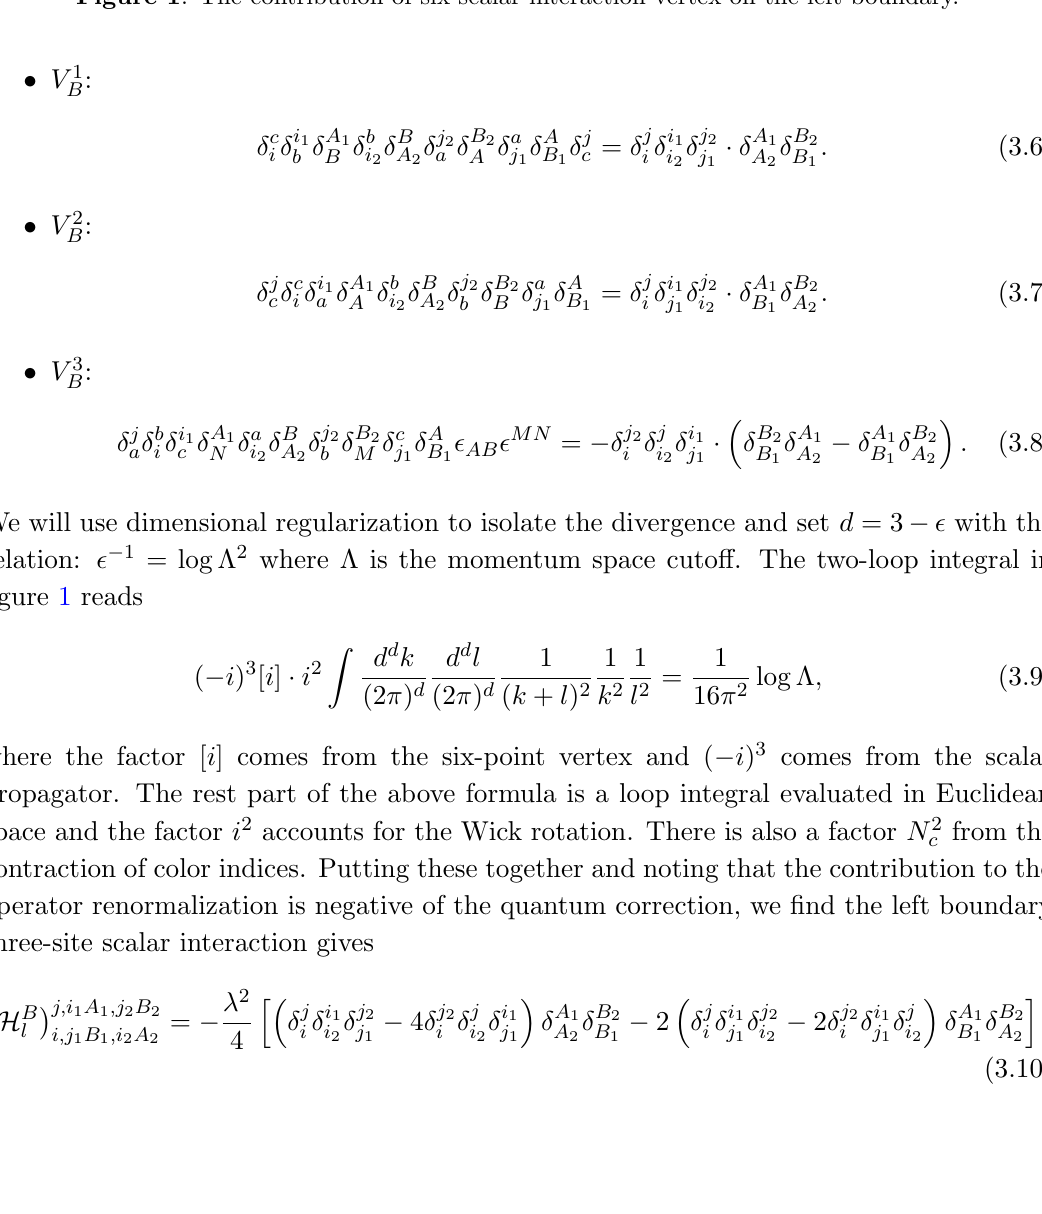
Figure 1 . The contribution of six scalar interaction vertex on the left